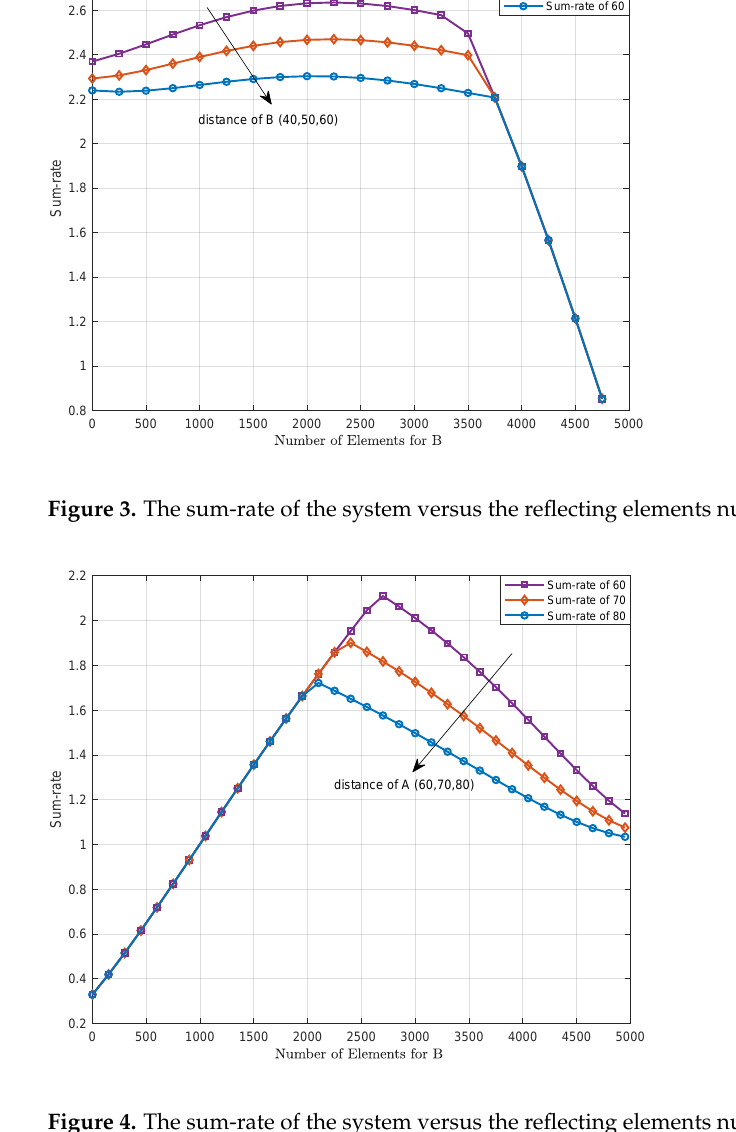
Figure 4. The sum-rate of the system versus the reflecting elements number with a fixed